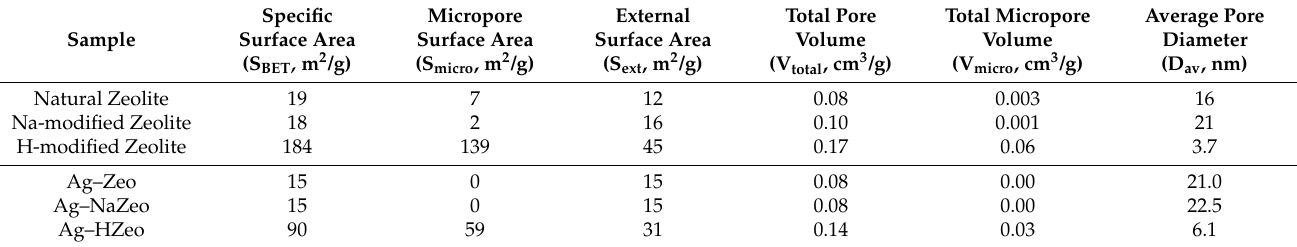
Table 2. Specific surface area and pore size for samples Ag–Zeo, Ag–NaZeo, Ag–HZeo and their corresponding precursors. Specific Sample Surface Area Natural